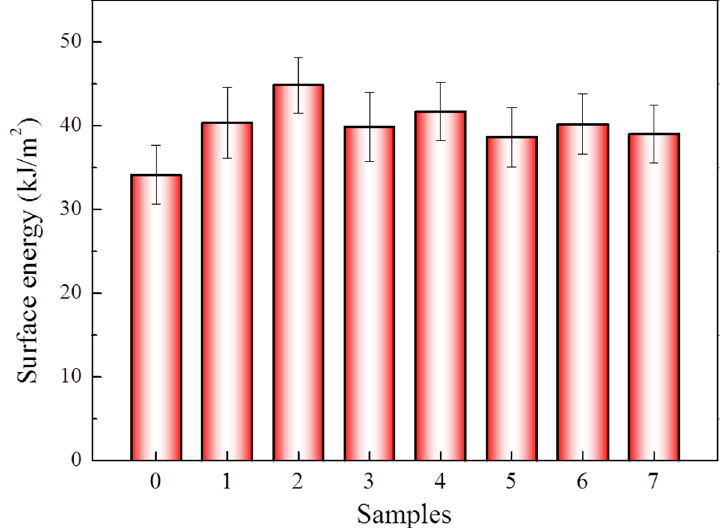
Figure 2. Surface energy of the aramid fibers before and after being treated with different conditions. (0): untreated fiber; (1–7): modified fiber of samples 1–7 in Table 1. All specimens were tested for 10 samples, and the average value was considered to be the tested value. The vertical bars represent the standard deviations in the measurement.